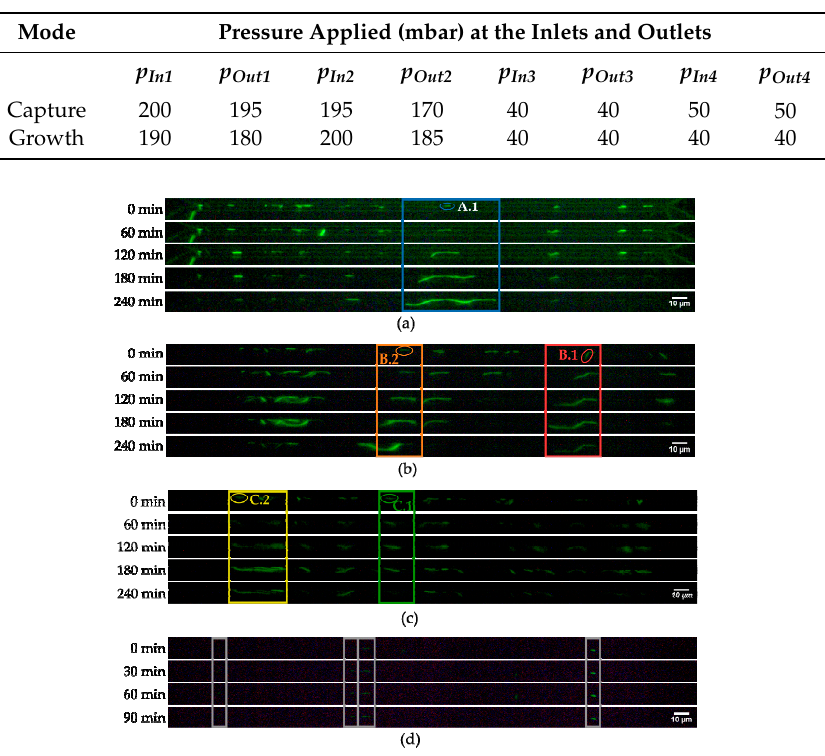
Figure 5. ( a) Schematic top view and ( d ) cross-section with flow conditions for ( b ) capture and ( c ) growth in the BCF chip with black arrows indicating the fluidic flow directions. Table 1. Applied pressure settings to inlets ( p In1 –p In4 ) and outlets ( p Out1 –p Out4 ) of the microchip for growth experiments in capture and growth modes.